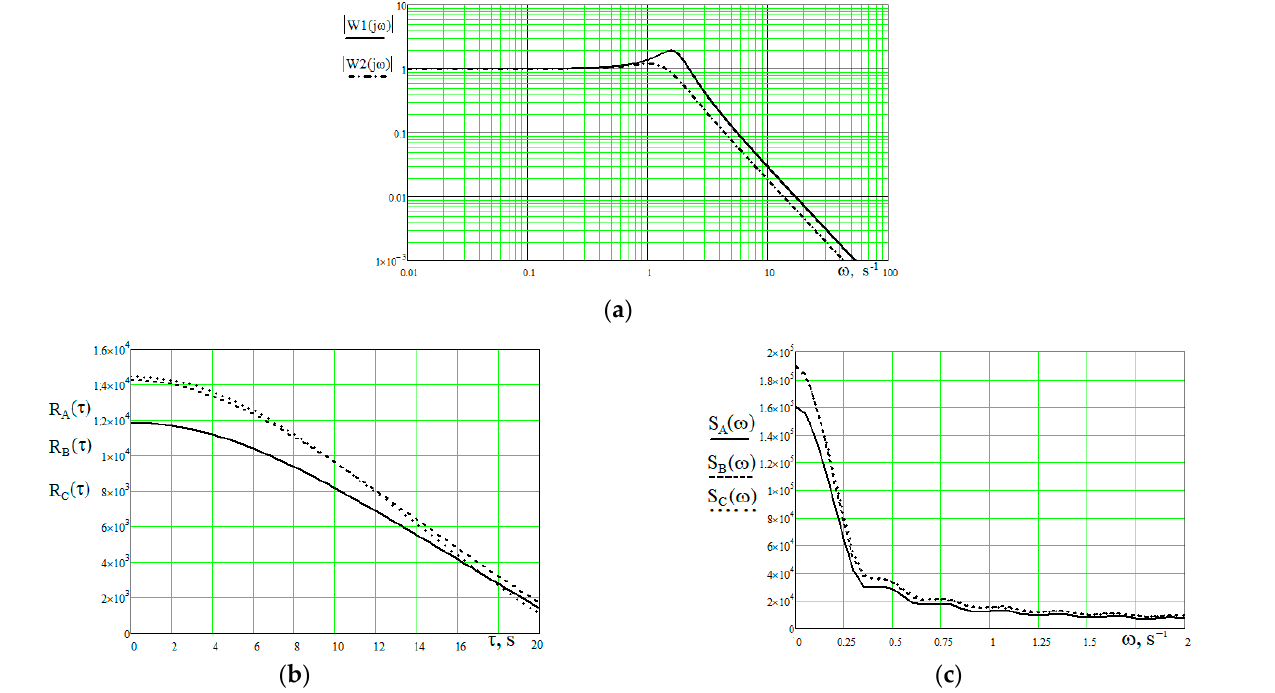
Figure 9. Logarithmic amplitude-frequency characteristic: ( a ) of the filter (10); ( b ) correlation func- tions; ( c ) functions of spectral density of perturbations formed in the phase channels of the model.